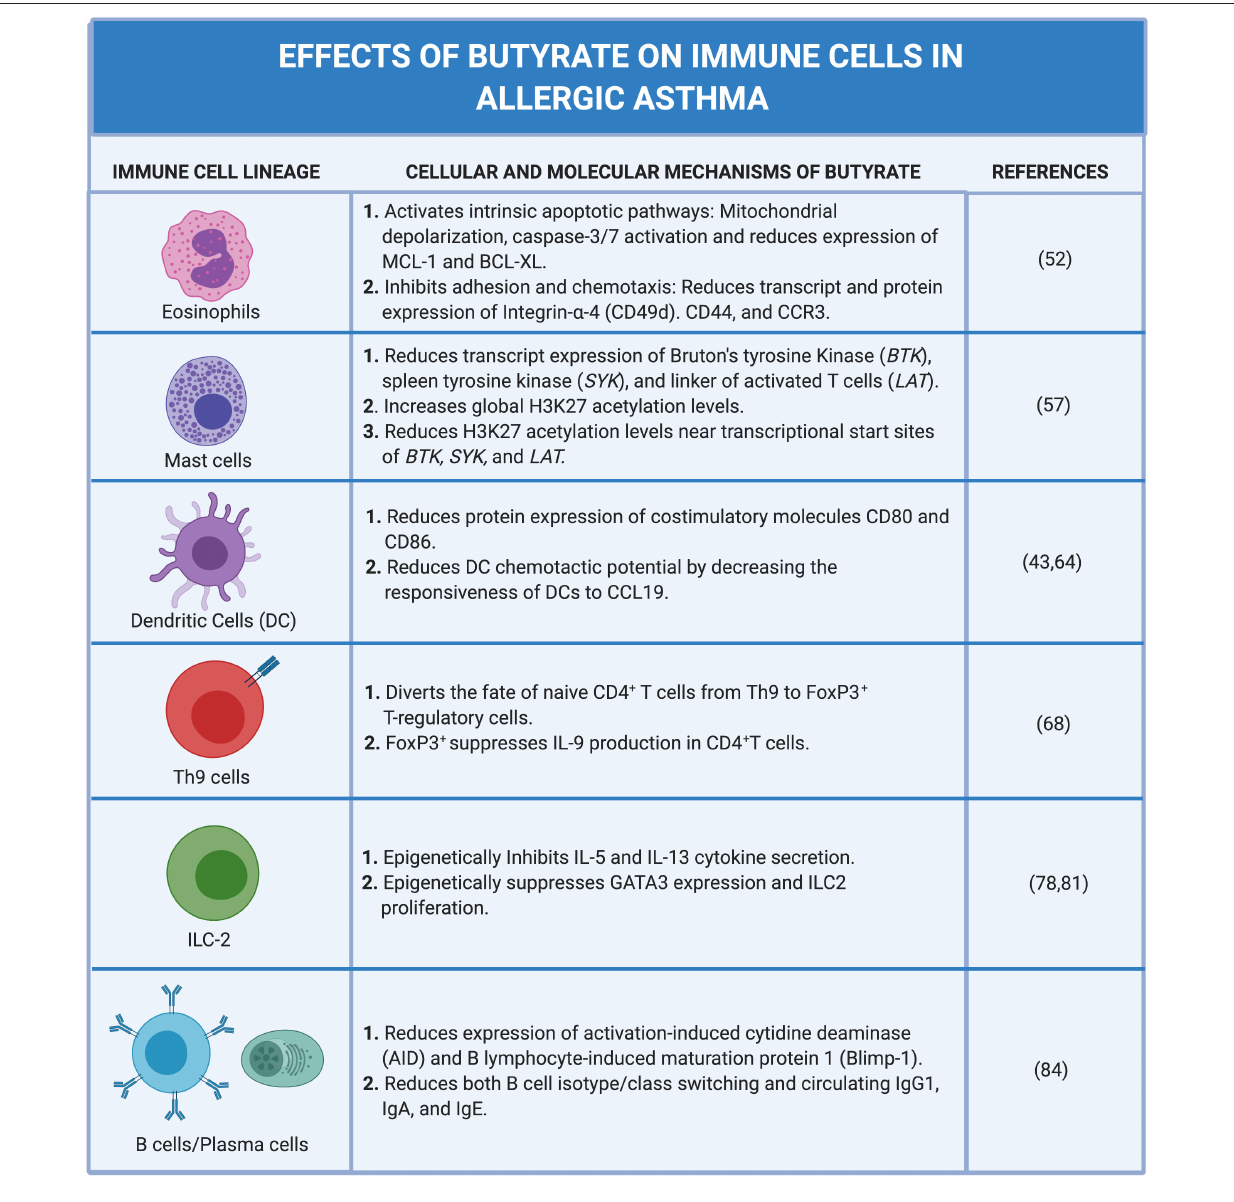
Frontiers in Immunology |